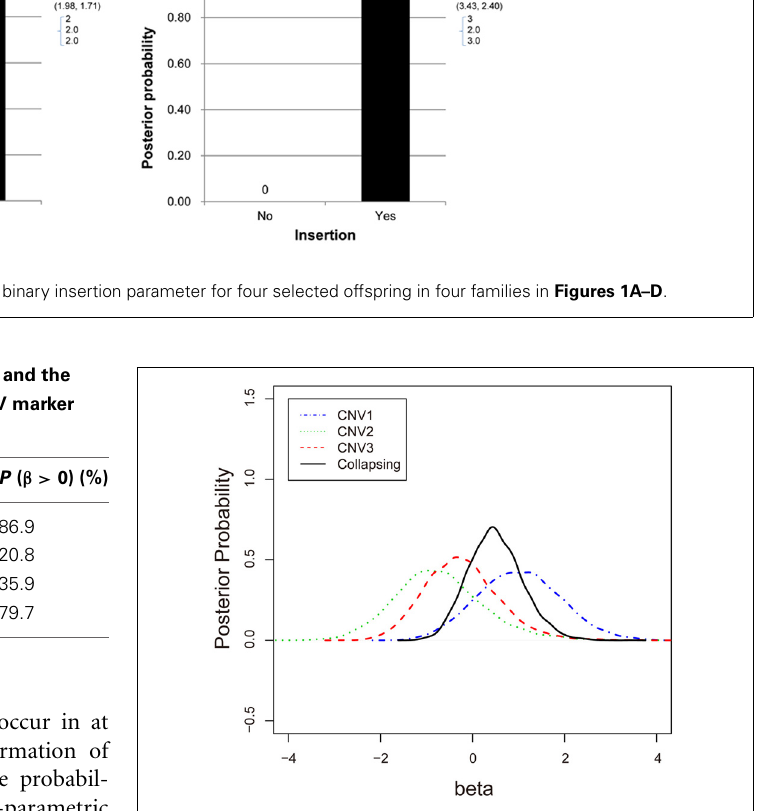
FIGURE 3 | The posterior probabilities of β under three single-CNV models and one multiple-CNV model.